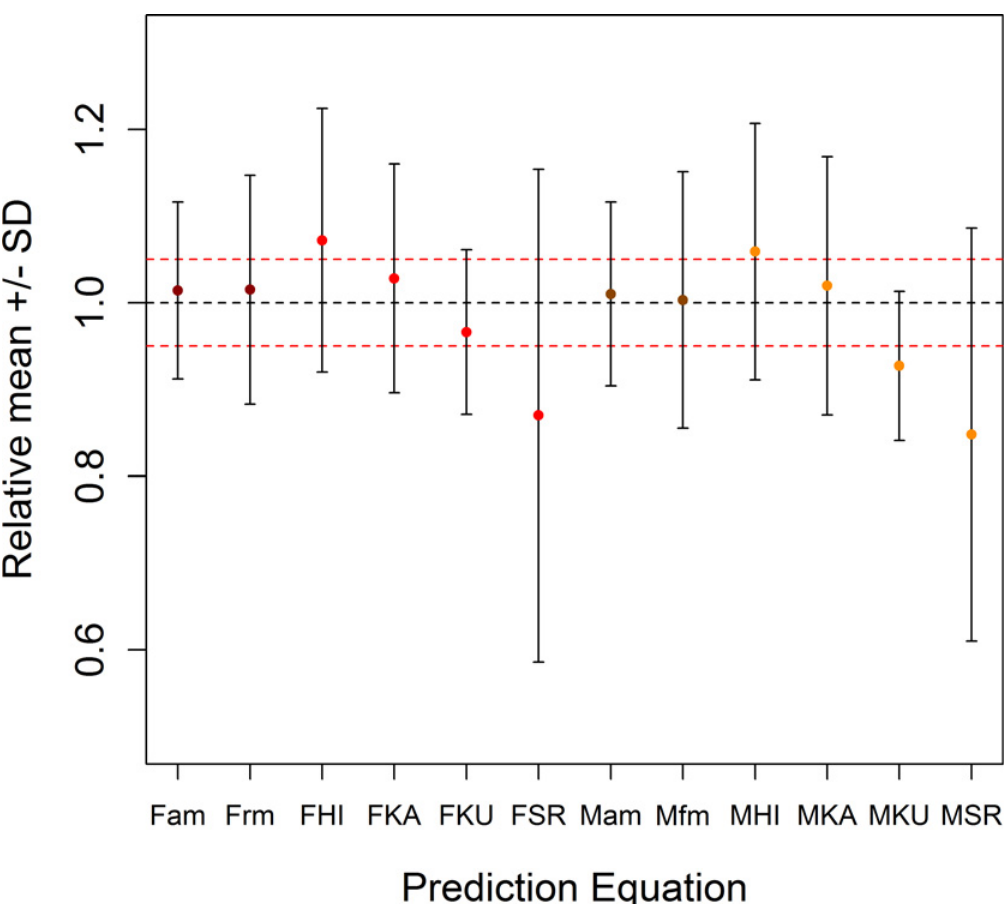
Fig 4. Mean and standard deviations of new and previously published prediction equations. Grey bars represent the entire range of the equation and the red dashed line represents 5% above and below one. Letter codes in the x-axis labels are as follows: F = Female; M = Male; KU = Kurt and Garai [36]; HI = Hile et al. [37]; KA = Kanchanapangka et al. [40]; SR = Sreekumar and Nirmalan [39]; am = Age model equations (Eqs 1 and 3); rm = Reduced model equations (Eqs 2 and 4). Red circles represent females, and orange circles males. Darker circles indicate the equations proposed in this paper.